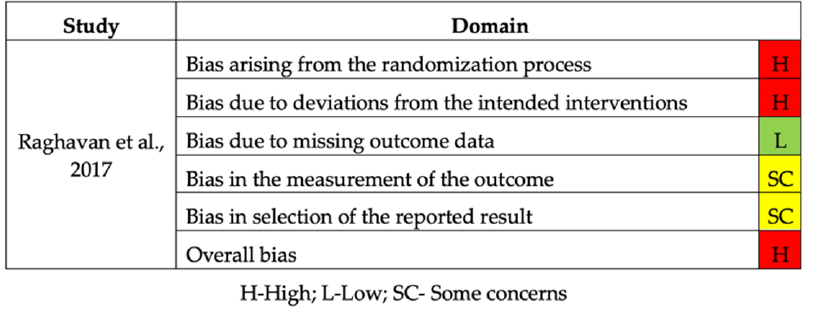
Figure 4. Risk of bias of the RCT study .